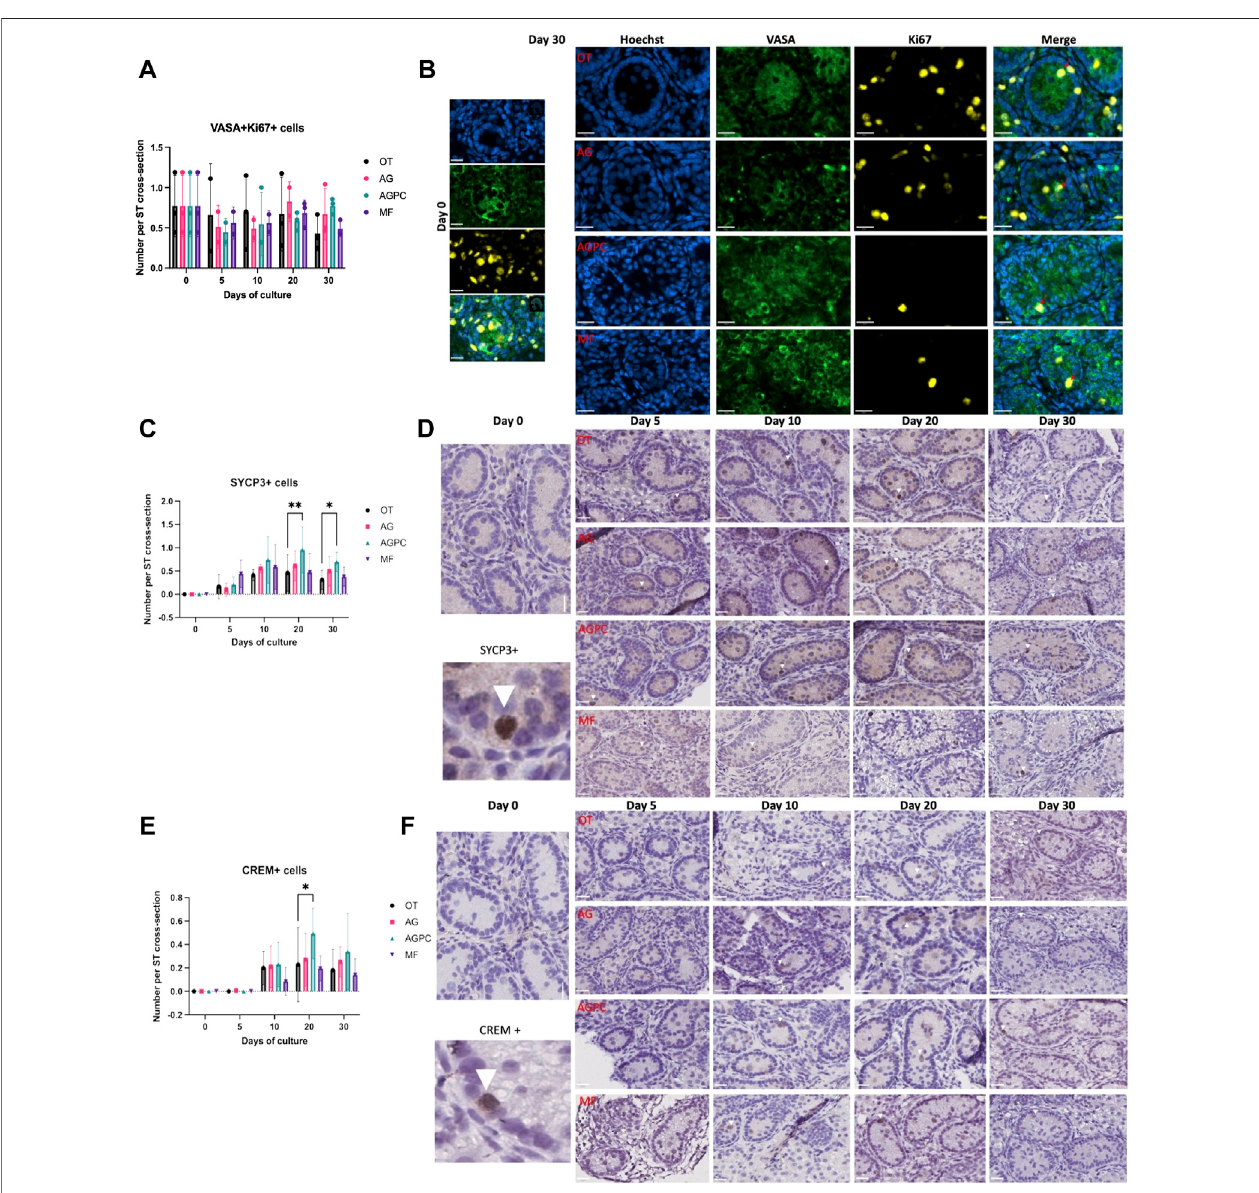
FIGURE4| Evolutionofgermcellproliferationanddifferentiationoverthecultureperiod. (A) Evolutionofthenumberofproliferatinggermcells(VASA+Ki67+)cells per ST cross-section over the culture period. (B) Immuno fl uorescence duplex staining for VASA/Ki67, red arrows indicate proliferating germ cells. (C) Evolution of the number of meiotic (SYCP3+) cells per ST cross-section over the culture period. (D) SYCP3 staining on immunohistochemistry, white arrowheads show SYCP3+ staining. (E) Evolution of the number of post-meiotic (CREM+) cells per ST cross-section over the culture period, (F) CREM staining on immunohistochemistry, whitearrowheadsshowCREM+staining.OT,cultureinsertPTFE;AG,Agarose;AGPC,Agarose+PDMScover;MF,Micro fl uidic.Imagesshownat×400magni fi cation. Scale bars = 20 μ